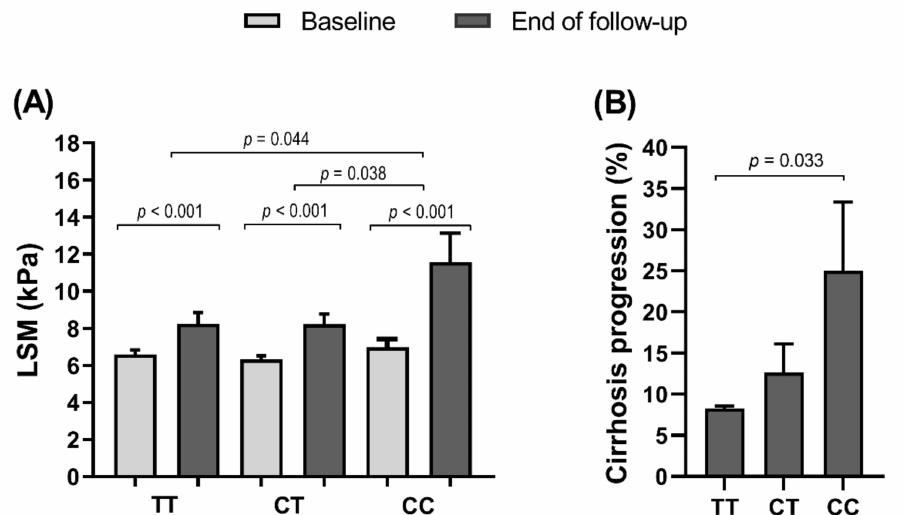
Figure 1. Summary of LSM values ( A ) and cirrhosis progression ( B ) stratified by TRPM5 rs886277 genotypes in HCV-infected patients. Abbreviations: HCV, hepatitis C virus; LSM, liver stiffness measurement; IFN, interferon; TRPM5 , transient receptor potential cation channel subfamily M member 5.